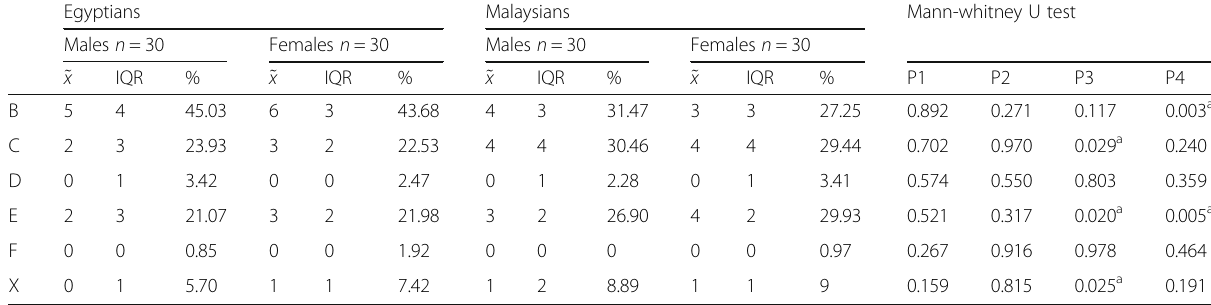
Table 1 Comparison of rugae shape among both sexes of Egyptian and Malaysian groups Egyptians